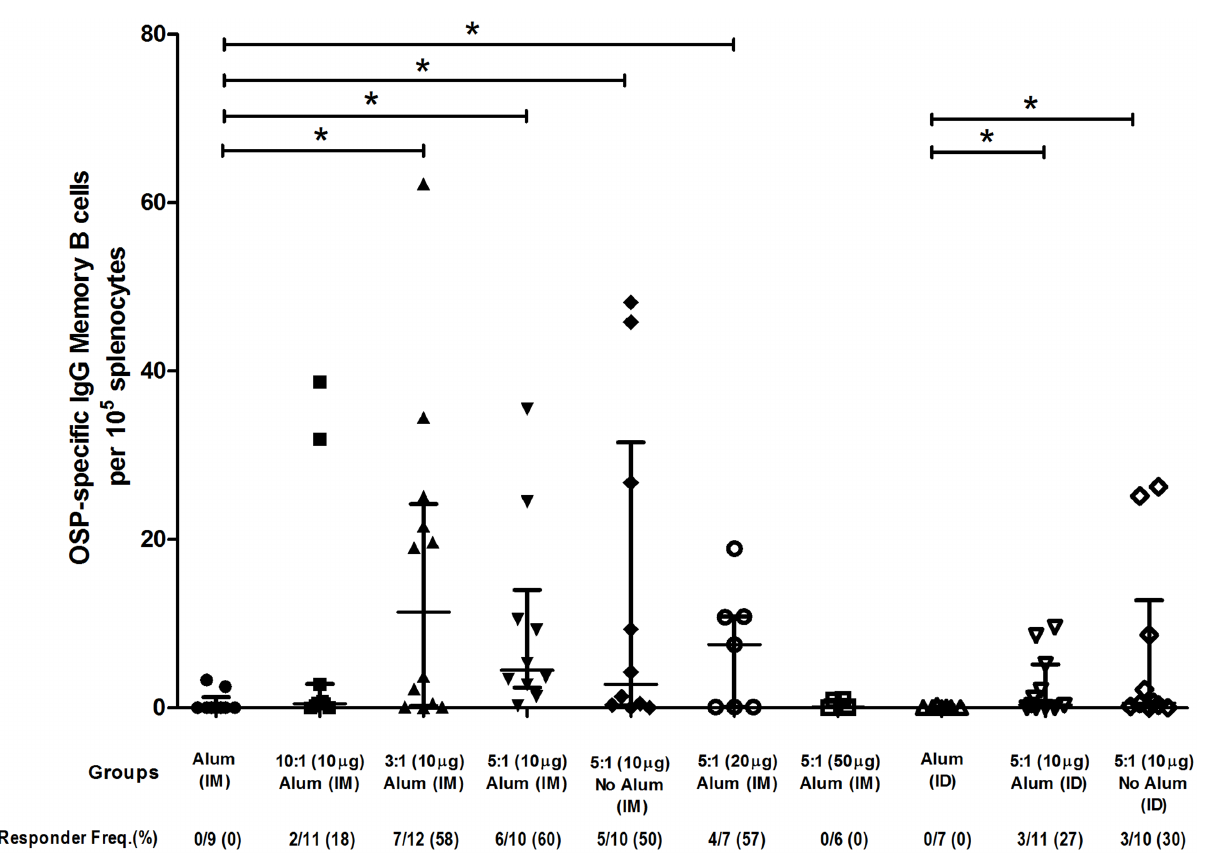
Fig 6. Memory B cell IgG responses in spleen at day 56 targeting O-specific polysaccharide (OSP) in various vaccine cohorts following intramuscular (IM) or intradermal (ID) immunization with various doses (based on OSP component) and/or loading ratios of OSP to TTHc, with or without adjuvantative alum. Mice were immunized on days 0, 21, and 42. Responder frequency reflects an increase of > 5 times total IgG secreting cells with stimulation versus no stimulation, and > 3.5 anti-OSP spots per 10 5 splenocytes. An asterisk denotes a statistically significant difference ( P < 0.05) in the mean response from the group immunized with only